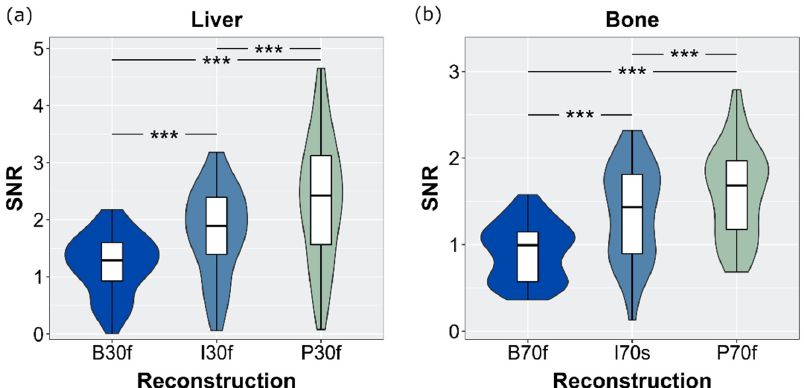
Figure 3. Signal to noise ratio calculated in the liver ( a ) and bone ( b ). Differences between the three reconstruction techniques were significant (*** p < 0.001).